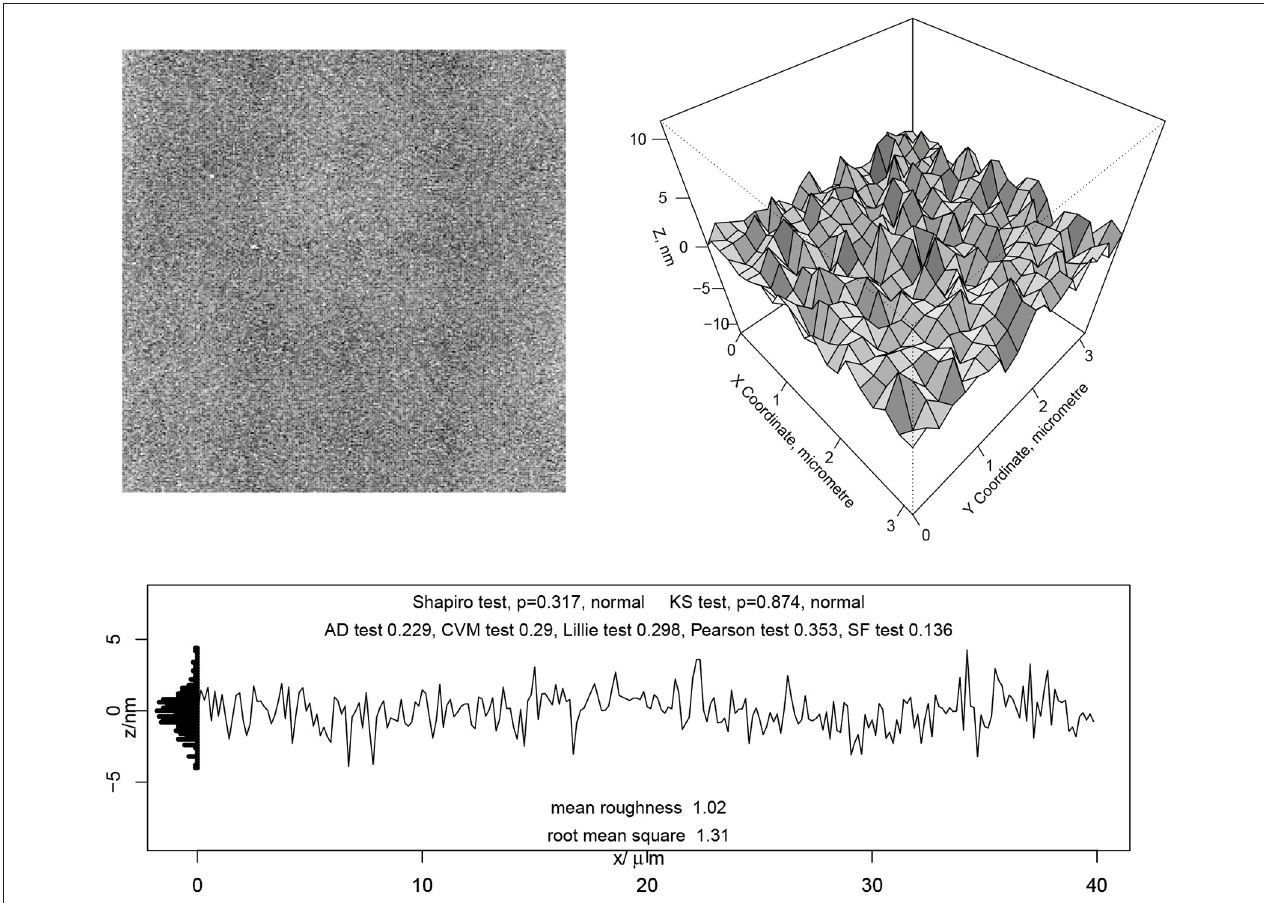
FIGURE 1 | The AFM scan of the a-C (bias) sample. (Left) full measured patch 40 x 40 µ m . (Right) extracted small region 3 x 3 µ m . (Bottom) A typical profile with normality tests and two descriptive statistics (values are in nm): the root mean square (rms) and the mean